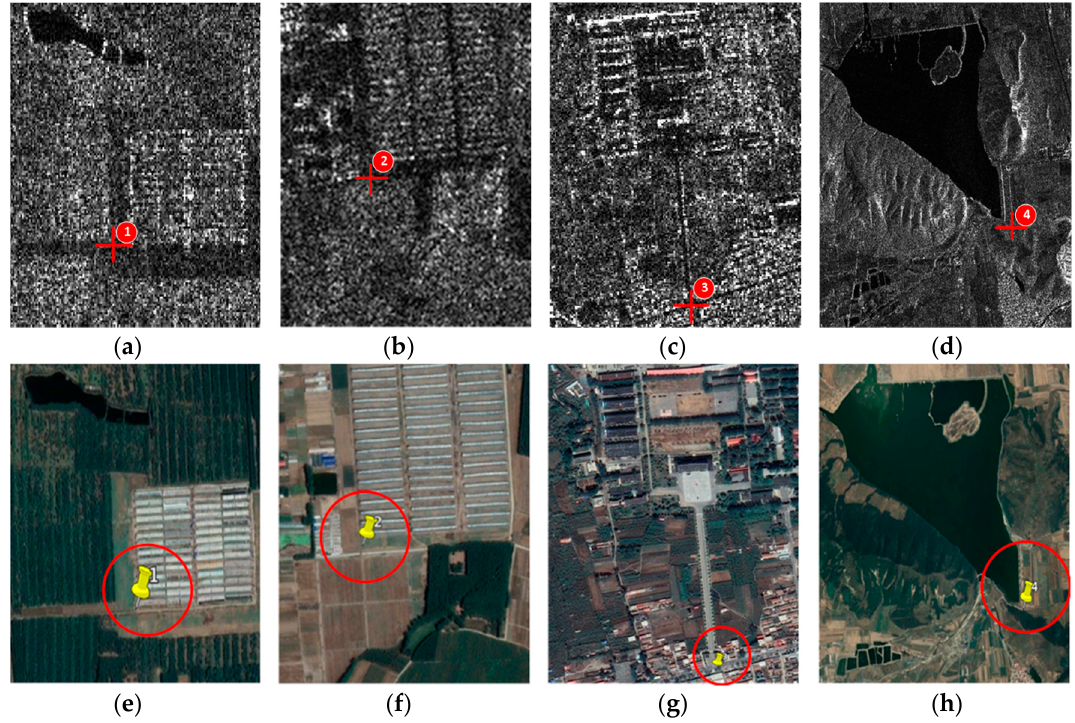
Figure 15. Scattering points: ( a ) the junction of the farmland; ( b ) the crossroad of the village; ( c ) the crossroad of the city; ( d ) the strong scattering point around the water area; ( e ~ h ) four check points on Google Earth.